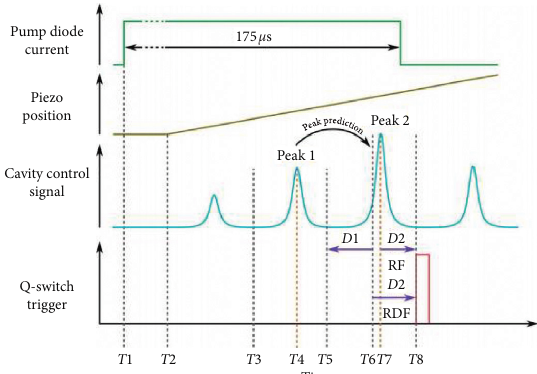
Figure 16: Schematic of the trigger mechanism of RDF resonance detection technology [65].